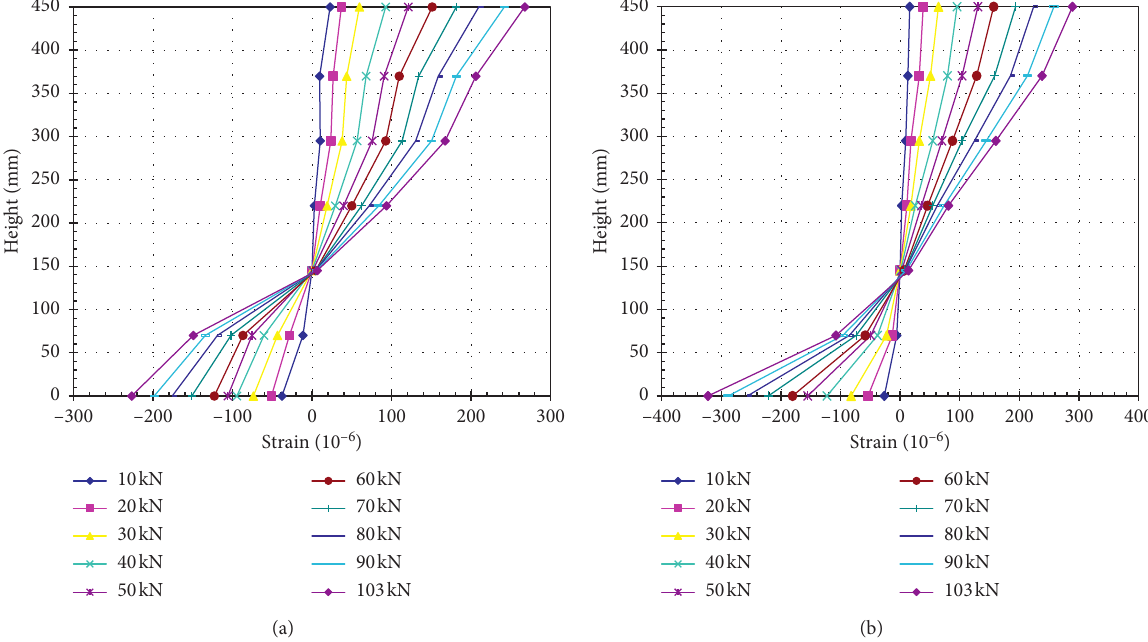
Figure 31: Curve of strain of PLG-2 steel beam with height. (a) Center line section (after 1 million cycles). (b) 0.5 times the beam height section (after 1 million